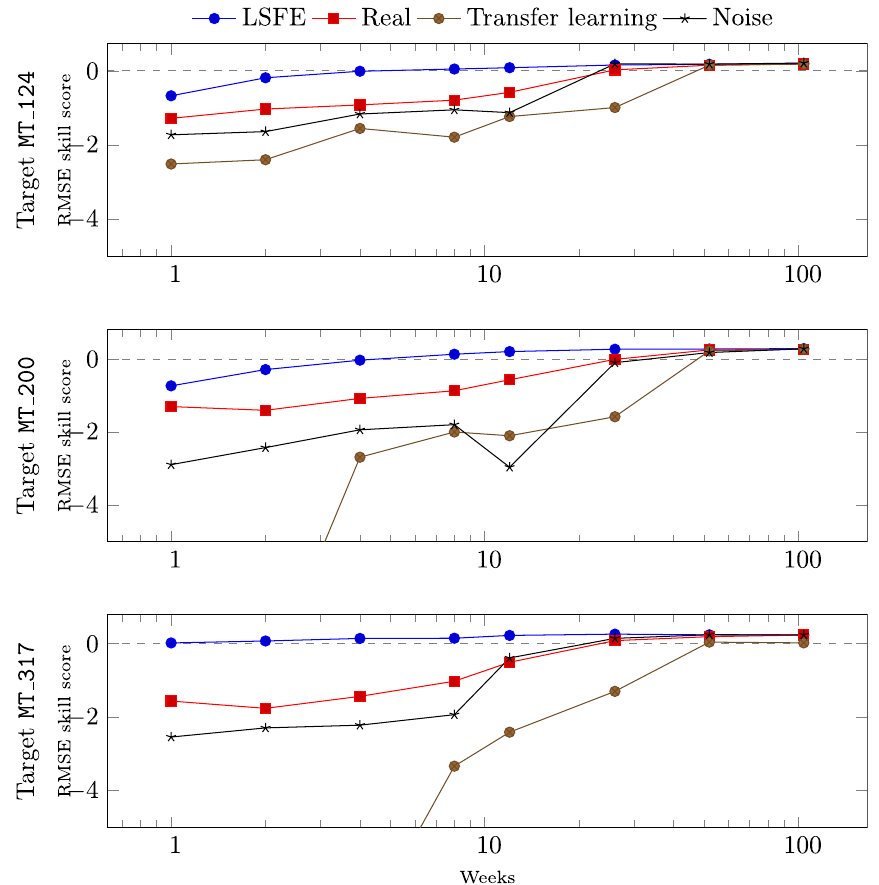
Fig. 10 The RMSE skill score with the persistence forecast as RMSE base of the LSFE using a cINN and the three benchmark models for different amounts of available target data and the three considered target data ( MT_124 , MT_200 , and